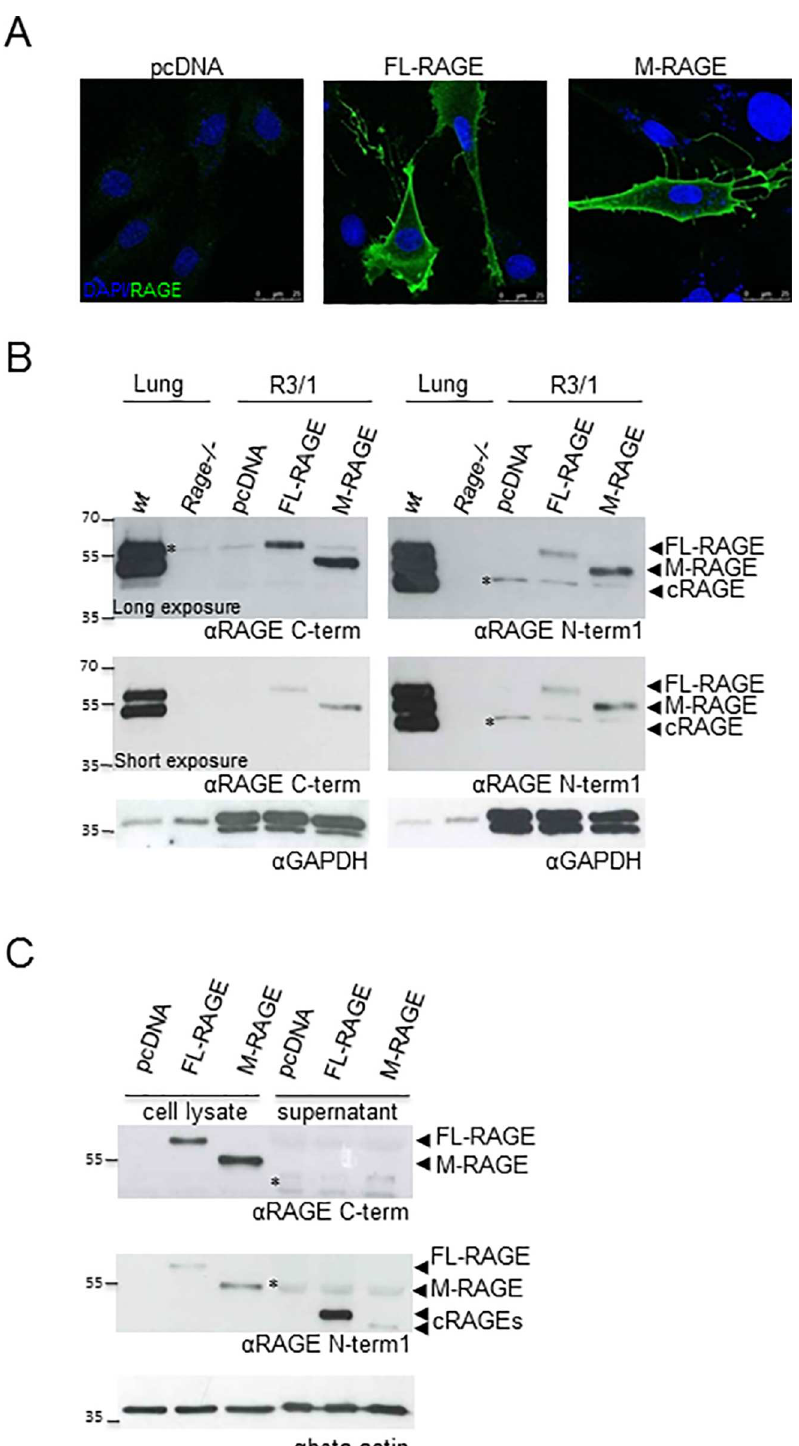
Fig 2. M-RAGE is highly resistant to shedding. (A) Cellularlocalization of FL-RAGE and M-RAGE. R3/1 cells were transfected with the empty vector (pcDNA), FL-RAGE or M-RAGE and IF staining was performed using the RAGE N-term antibody (green) that recognizes the extracellular domain. Nuclei were stained with DAPI (blue). Bars correspondto 25 μ m. (B) FL-RAGE and M-RAGE are readily detectable in mouse lung. Representative WB of twenty μ g of lysate from one Rage-/- and one wild type (wt) lung and 35 μ g of